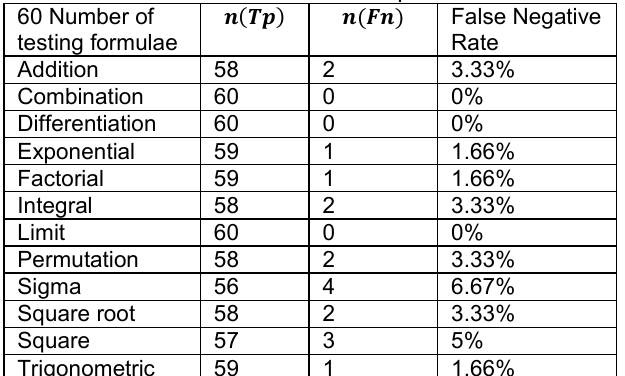
Table 12. The above tabulated value represents overall FNR Measure with Tensorflow from a document of 60 samples.